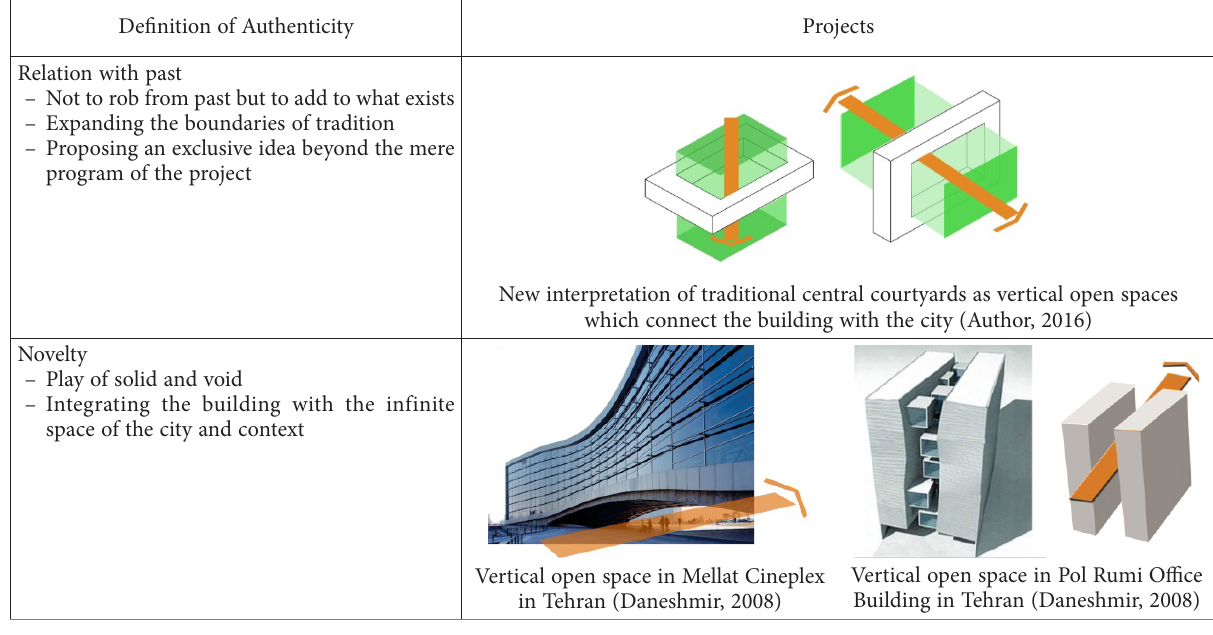
Table 2. Compatibility with typology of traditional architecture and surrounding context as authentic features